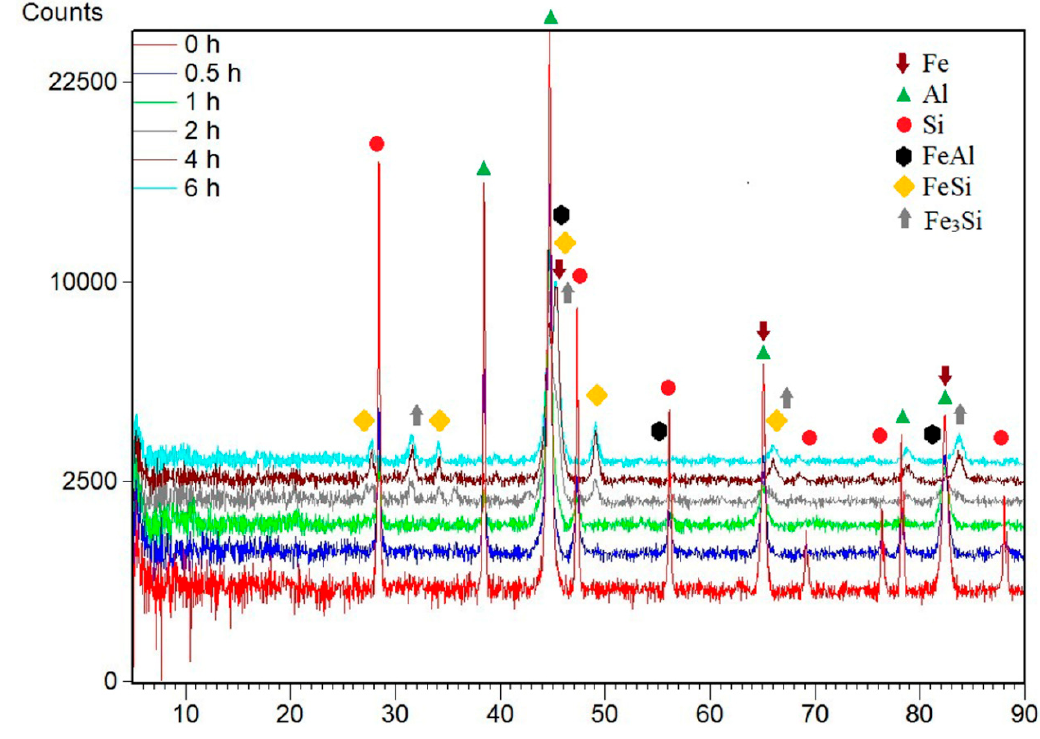
Figure 3. Phase composition of FeAl20Si20 alloy vs. milling time. Table 3. Phase composition vs. milling time for FeAl20Si20 alloy.